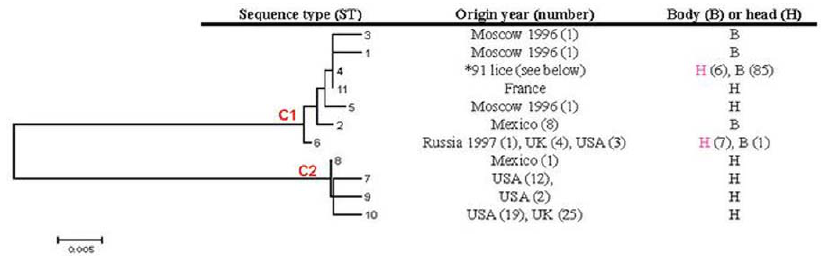
Figure 3. Phylogenetic organization of 170 human lice based on partial cytB gene using using the neighbor-joining method.